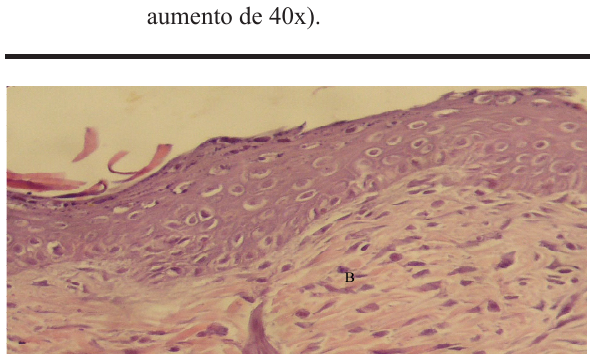
FIGURA 11 - Fotomicrografia do grupo experimento do 14º dia. Nota: Epitelização parcial (A), moderada proliferação de fibroblastos (B) e formação de colágenos (C) (H-E com aumento de